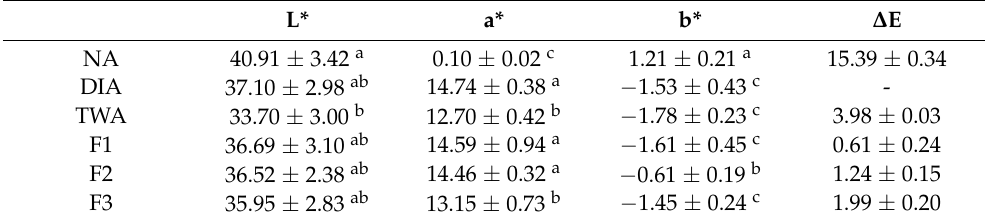
deionized water-dissolved BRA (DIA), colored with tap water-dissolved BRA (TWA), and colored with tap water-dissolved BRA containing the three optimized chelator formulations (F1 – F3).